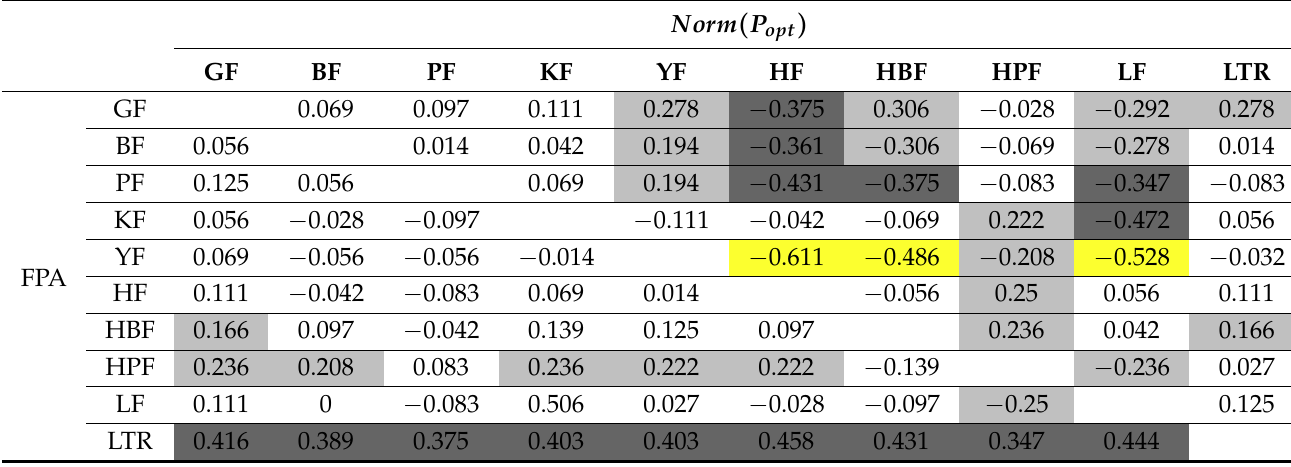
Table 5. Cliff’s δ of the Nine Training Data Selection Methods and LTR Trained on 10% WP Data in Terms of FPA and Norm ( P opt )